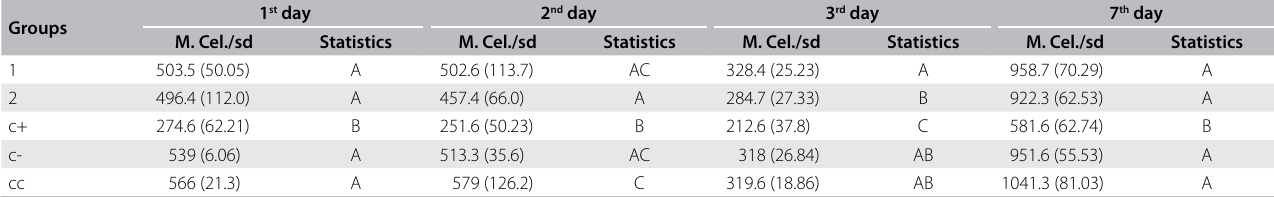
Table 1. Statistical analysis with means and standard deviations for the studied groups